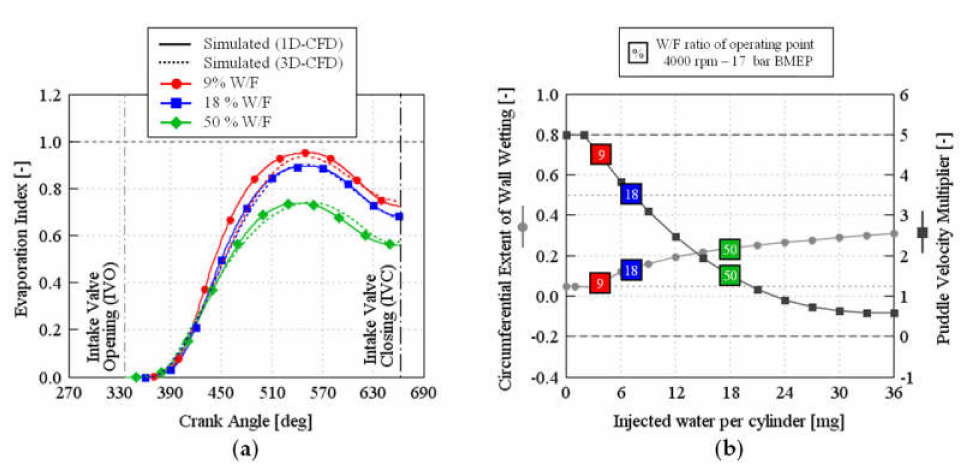
Figure 8. ( a ) Evaporation index measured during the 3rd cycle in a row of PWI at 4000 rpm—17 bar for Water-to-Fuel ratios of 9% (red line), 18% (blue line) 50% (green line); 1D simulation (solid line), 3D simulation (dashed line); ( b ) Optimized values of the calibration parameters for the port-puddling model as a function of the total injected water per cylinder.